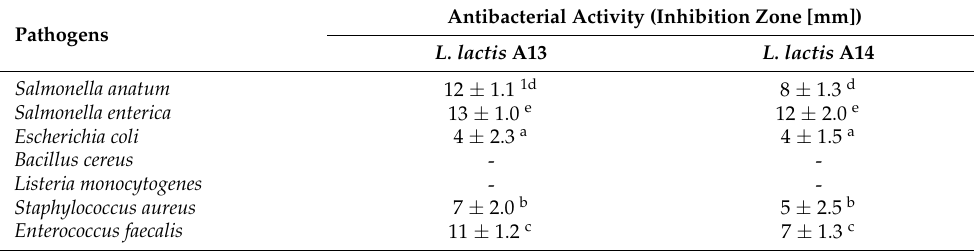
Table 5. Antibacterial activity of L. lactis strains against different pathogens. Pathogens